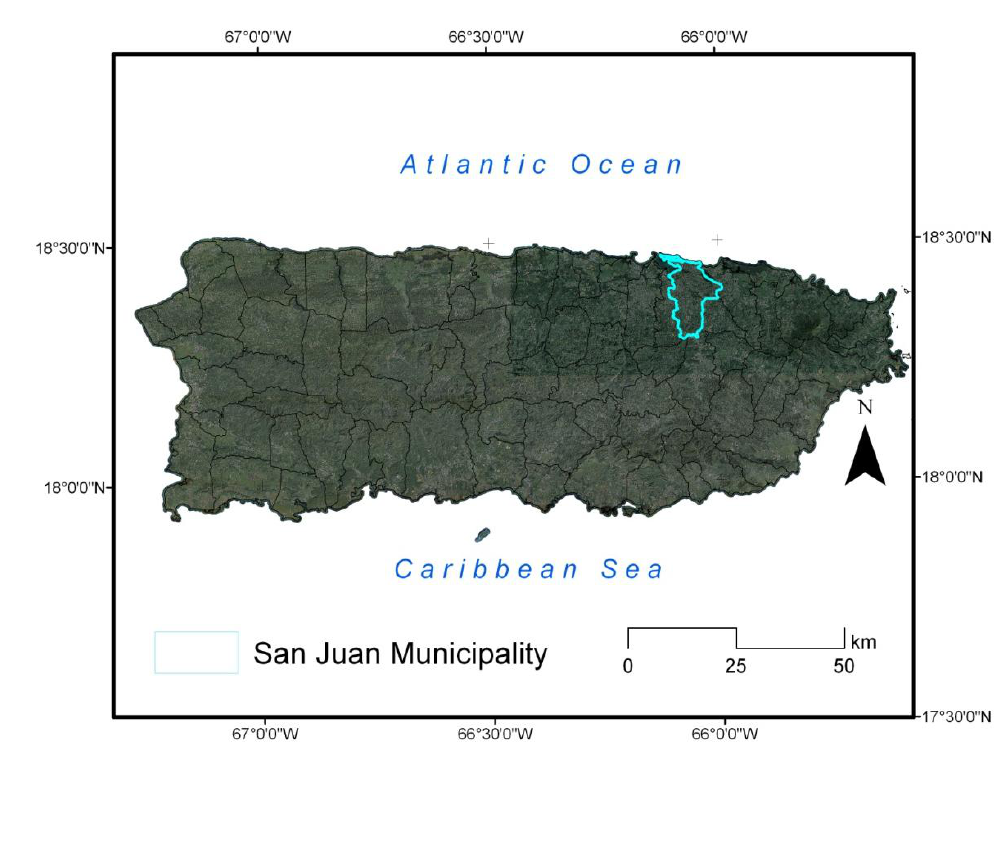
Figure 1. Puerto Rico and location of the municipality of San